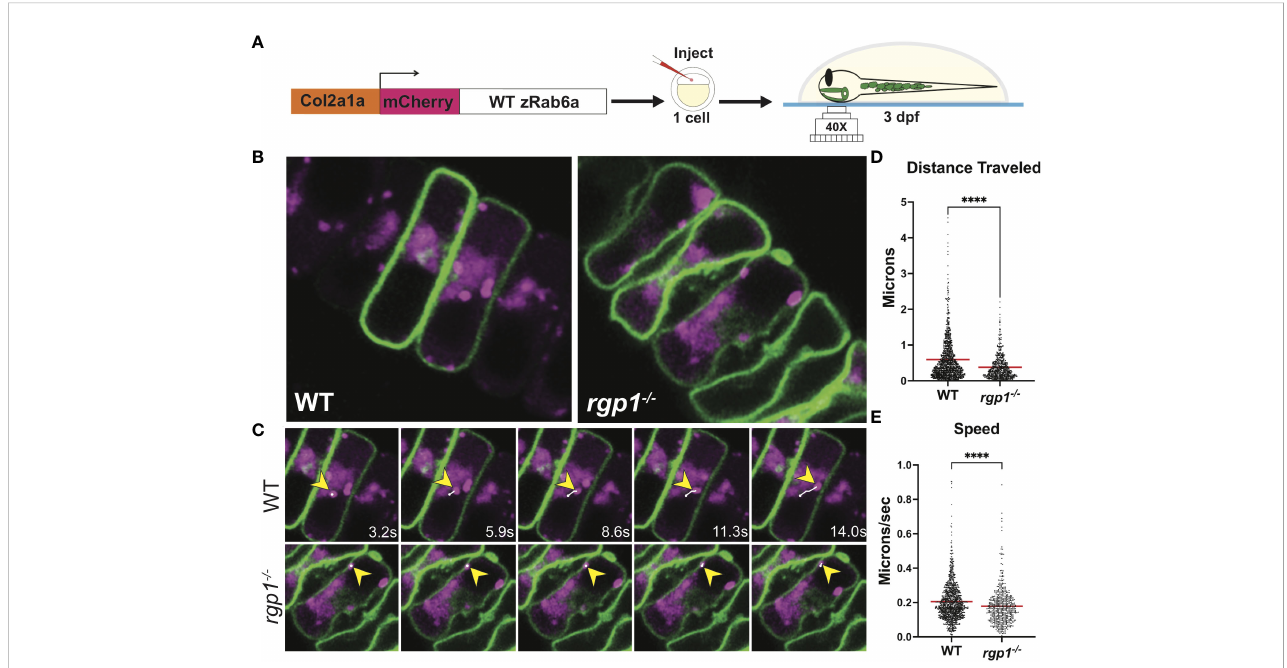
FIGURE 2 Rab6a vesicle traf fi cking is reduced in rgp1 -/- chondrocytes (A) Experimental design for mosaic overexpression of WT mCherry-zRab6a fusion protein in Tg(Col2a1 a :caax-eGFP) transgenic zebra fi sh chondrocytes for live imaging. (B) Representative images from movies of mCherry-zRab6a vesicular compartment movement in chondrocytes (Supplemental Movies 1, 2). (C) Montage of mCherry-zRab6a puncta progression at speci fi c times in WT and rgp1 -/- chondrocytes (yellow arrowheads) showing path of indicated vesicle over time (white line). (D) Quanti fi cation of vesicular compartment distances traveled in WT and rgp1 -/- chondrocytes. Red lines indicate means. (E) Quanti fi cation of vesicular compartment speeds in WT and rgp1 -/- chondrocytes. Red lines indicate means. Signi fi cance is presented by